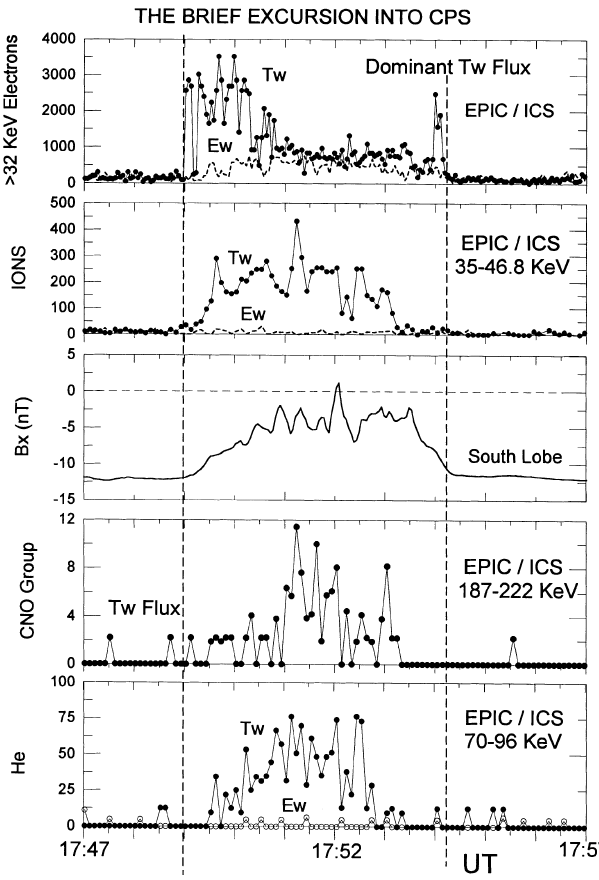
Fig. 6. A GEOTAIL brief excursion from the south lobe toward the CPS and then back to the lobe structure, as it is seen along the magnetic field B component at the central panel . The >32-keV x electrons ( first panel ) stream tailward ( solid dotted line ) at the PSBL regions, whereas they show isotropic character at the CPS one. The tailward flux dominates along the 35–46.8-keV ion trace ( second panel ), the 187–222-keV CNO group trace ( fourth panel ) and the 70– 96-keV trace of He particles ( bottom panel ). The abrupt exit from the plasma sheet is accompanied by short-lived energetic